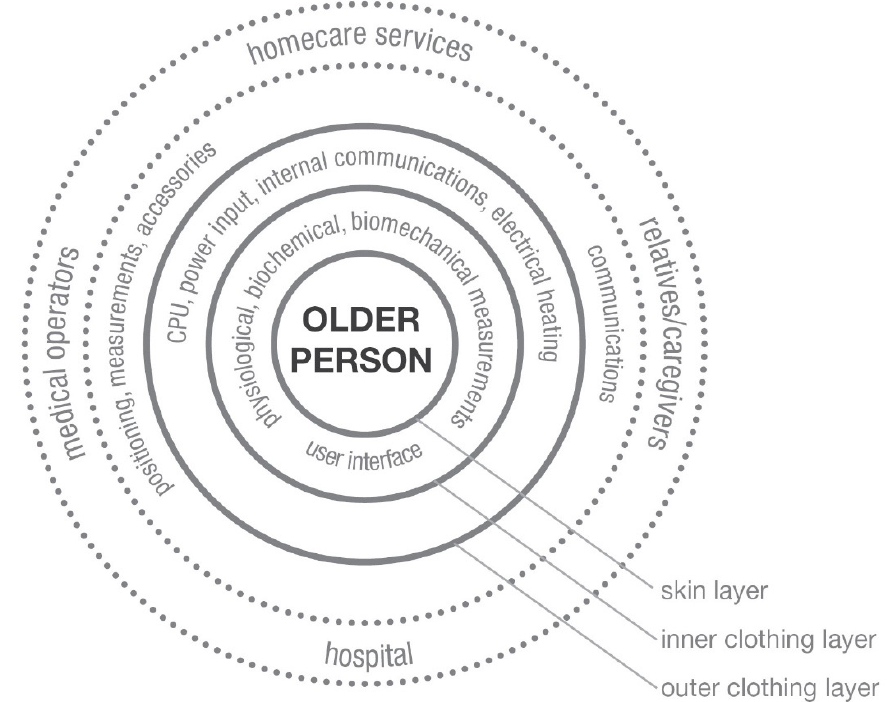
Figure 4. Evolution of the concept model of smart clothing for older users [43].